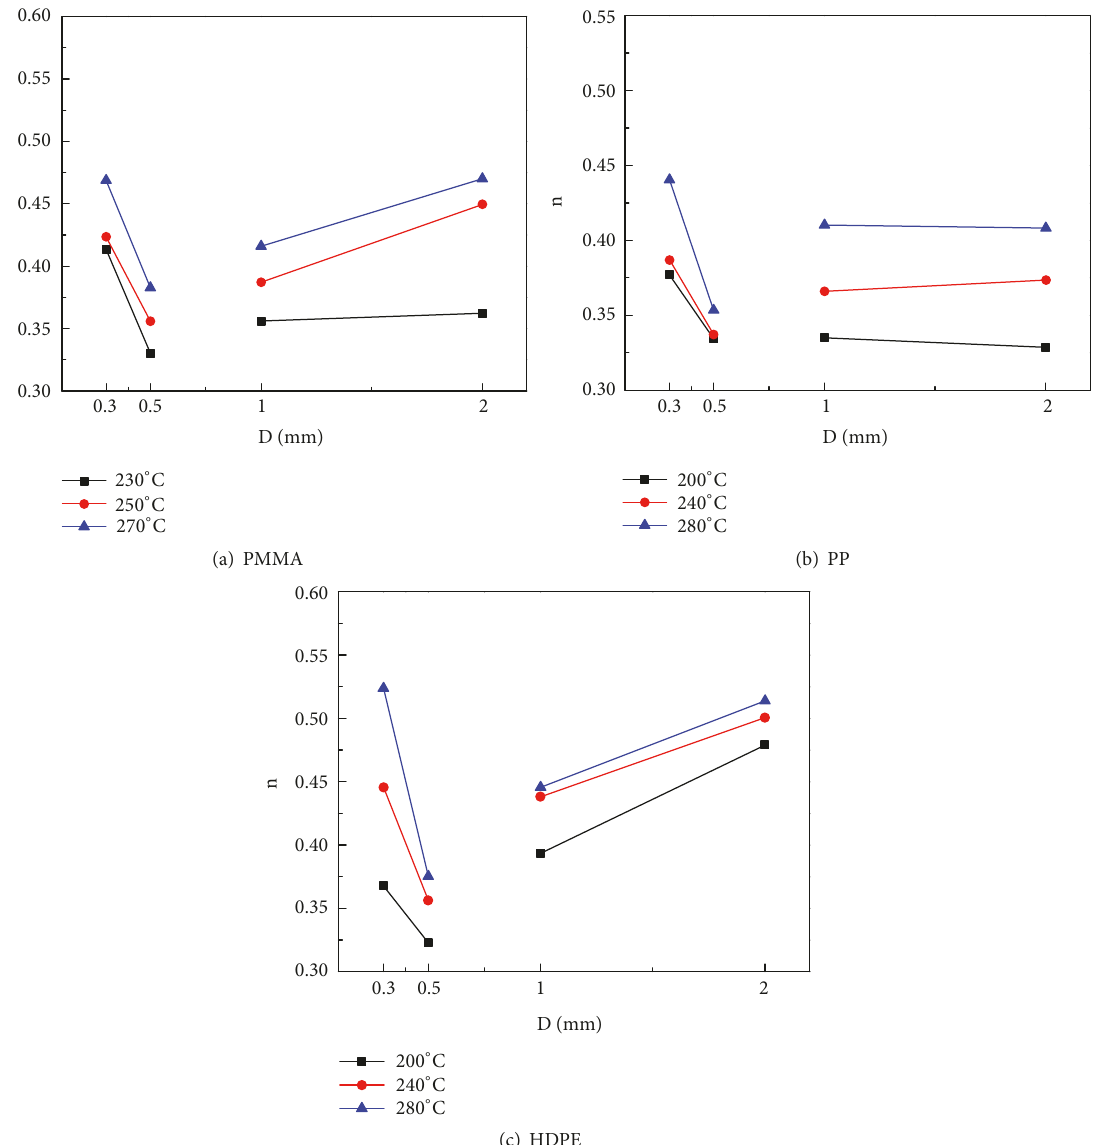
Figure 3: Non-Newtonian index of materials at both microscales and macroscales with different temperatures. (a) PMMA; (b) PP; (c) HDPE.